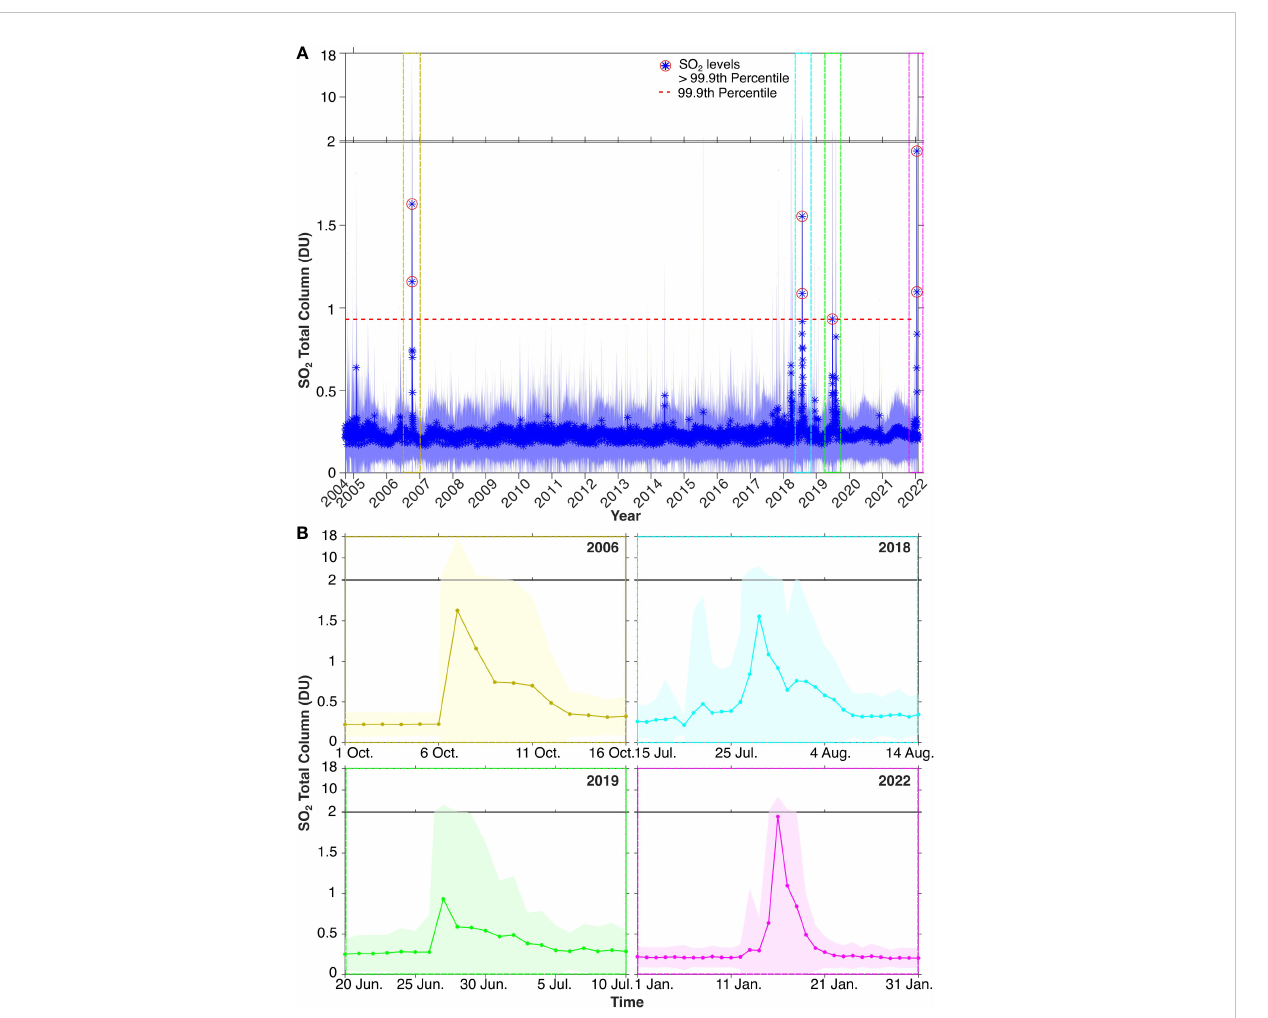
FIGURE 1 The temporal variation of OMI-derived mean SO 2 total column averaged over the western SPO (10°N – 35°S, 125°E – 150°W) (A) for the study period of October 2004 to February 2022, enlarged fi gures (B) for October, 2006, July to August, 2018, June to July, 2019 and for January, 2022. The asterisk markers and blue lines in (A) (circle markers and shading in Figure 1B) indicate the mean and one standard deviation of mean, respectively. Red dotted line indicates the threshold of SO 2 value that correspond to 99.9th percentile. Red circles indicate the SO 2 values that exceeded 99.9 th